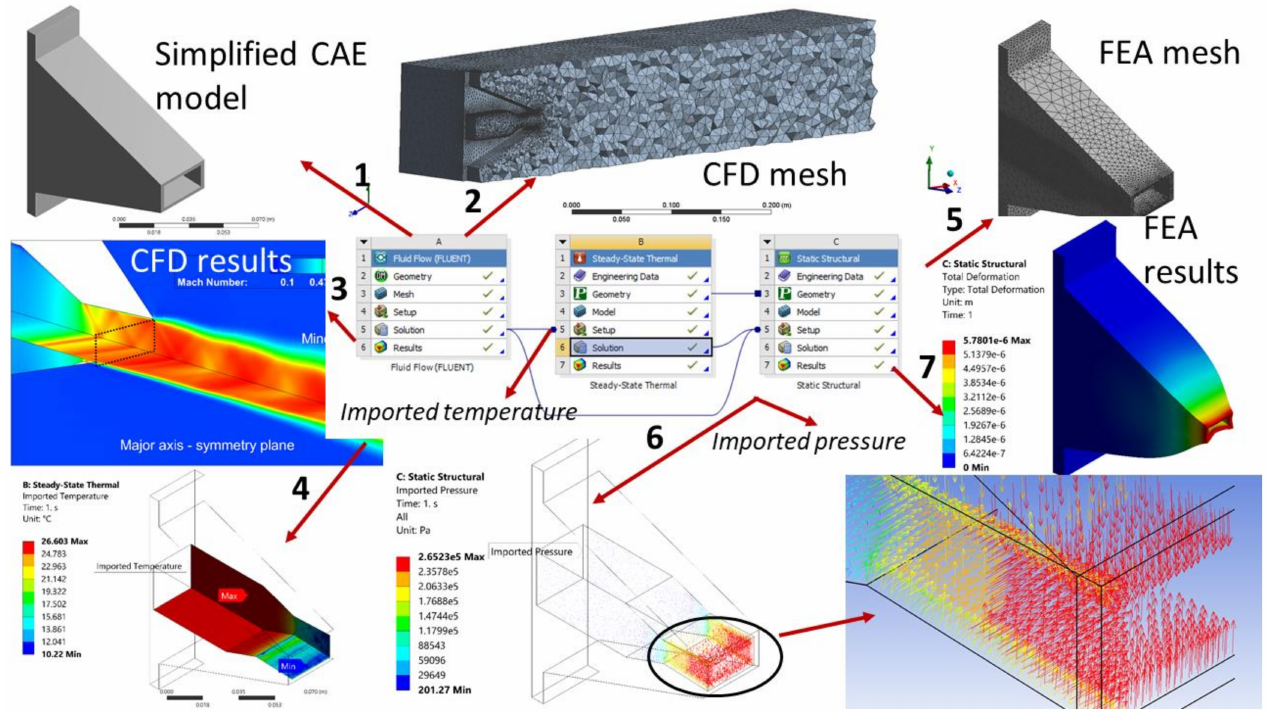
Figure 6. One-way FTSI methodology with the sequence of steps numbered as seen in the